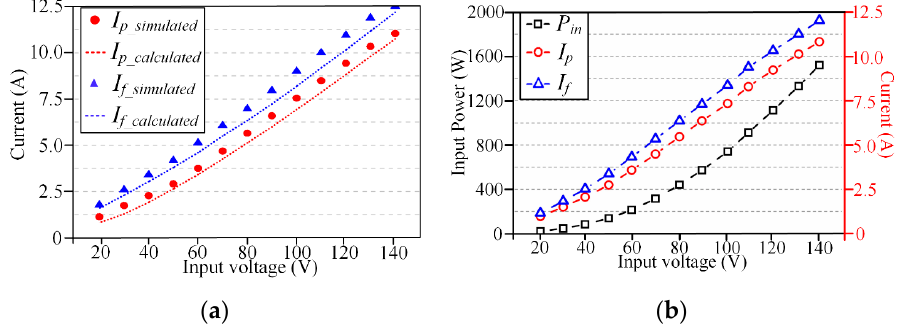
Figure 14. Currents and power control by the input voltage. ( a ) Calculated results. ( b ) Measured results.